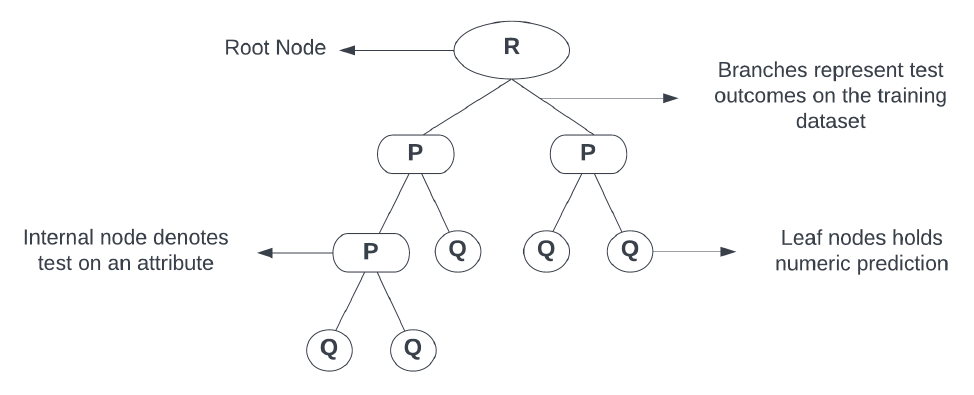
Figure 4. DT structure